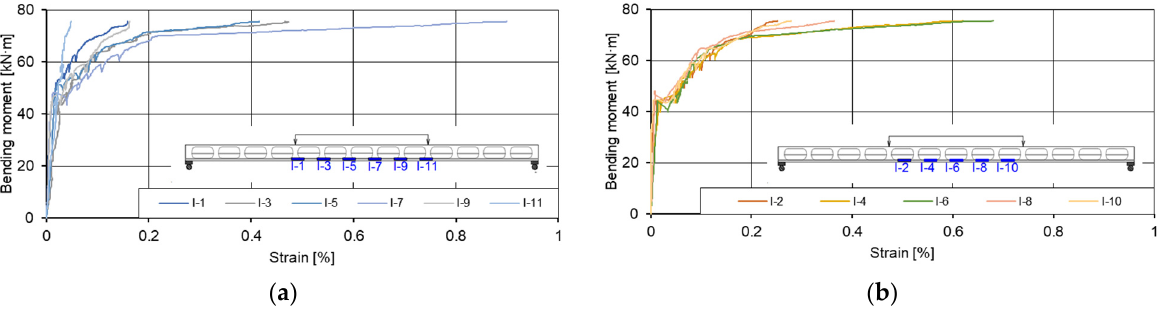
Figure 22. Graphs of bending moments: strains of the second slab (II pl) at the level of pretensioned reinforcement. ( a ) Strains between the plastic inserts and ( b ) strains at the place of the plastic inserts.